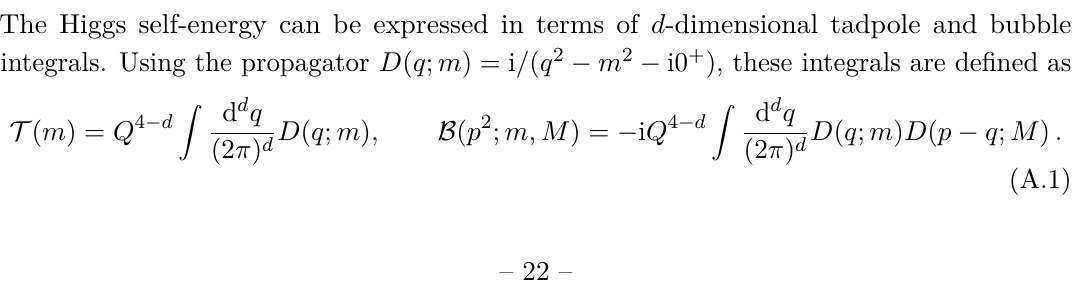
scheme used, as opposed to the case when the unity of the residue is not imposed. The OPT potential reproduces this benchmark potential to high relative accuracy (within 1